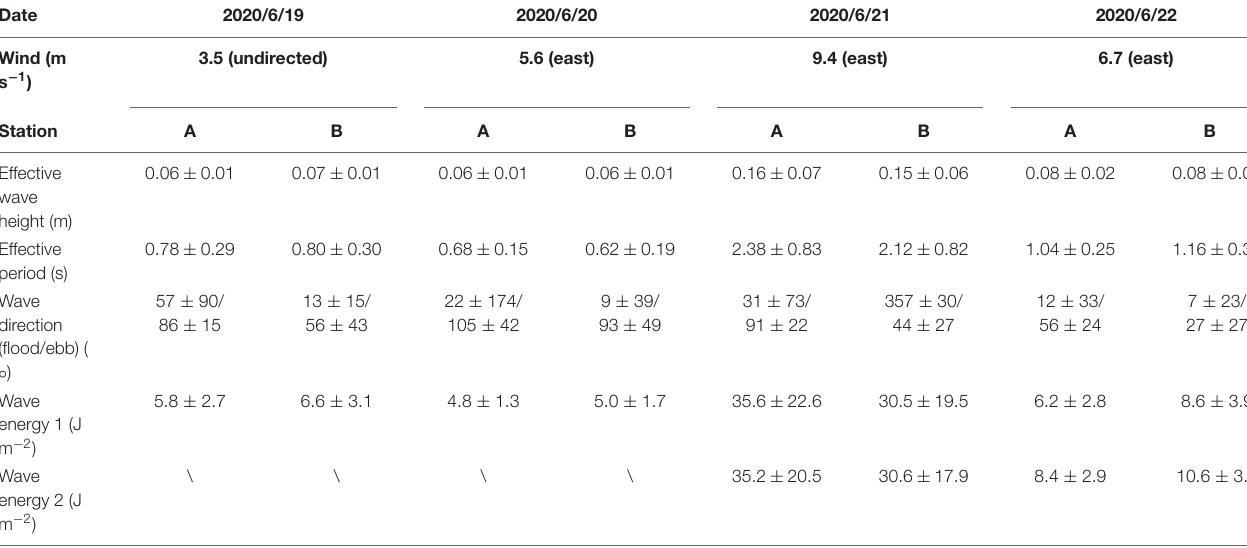
FIGURE 4 | Correlation analysis of wave energy measured by wave loggers and calculated by ADV data: (A–D) the comparison between wave loggers results and calculated results from phase method; (E–H) the comparison between wave loggers results and calculated results from pressure inversion wave method. Station A is mudflat site and Station B is patch center site; the observation took place on June 21 and June 22. TABLE 1 | Wind conditions and wave characteristics of stations A (mudflat) and B (vegetation) from 19th June to 22nd June,